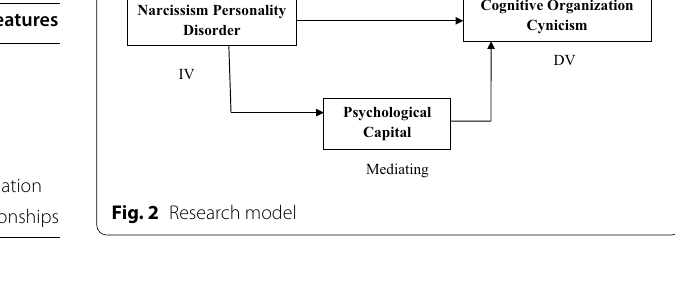
Table 1 Hedonic and eudemonic well-being. Source : Adler and Seligman [2]